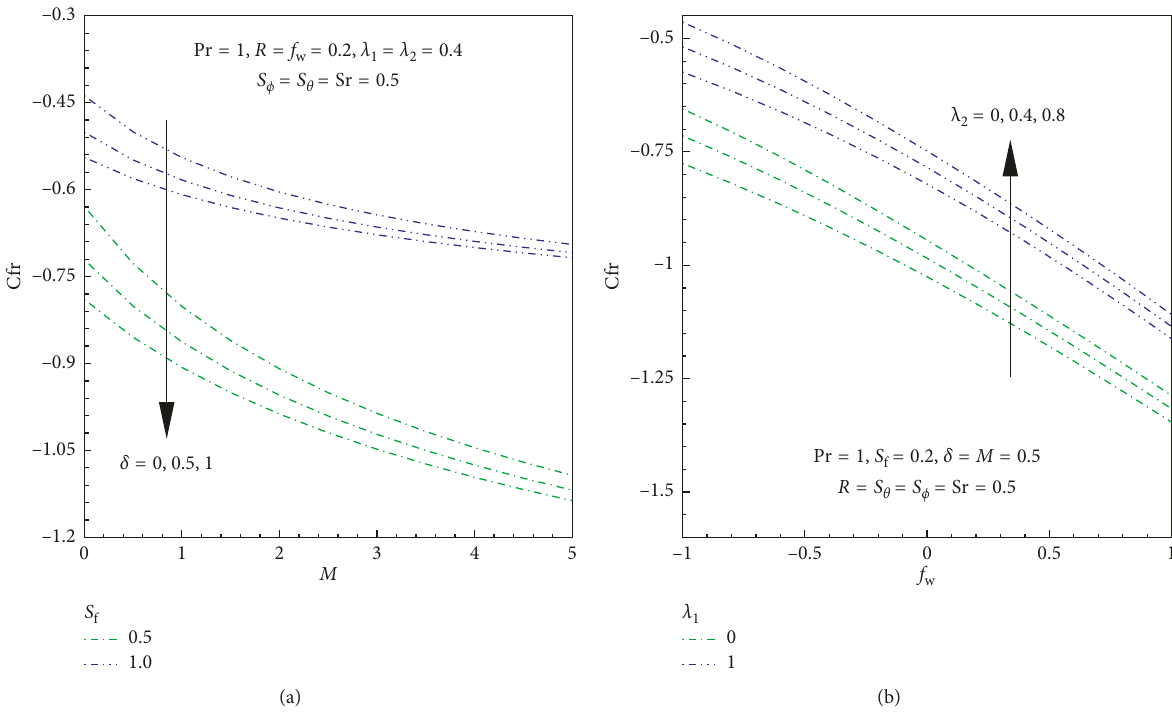
Figure 9: Effects of M, δ , S